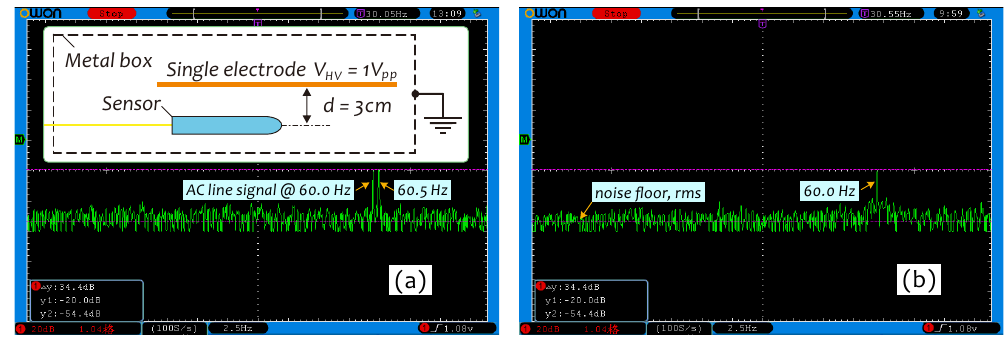
Figure 12. Two FFT spectra measured when ( a ) V HV = 1 V pp and ( b ) V HV = 0 V.